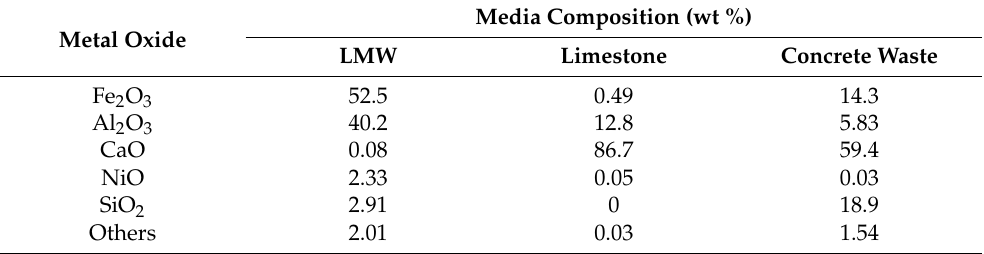
Table 5. Percent oxide composition of each treatment media.